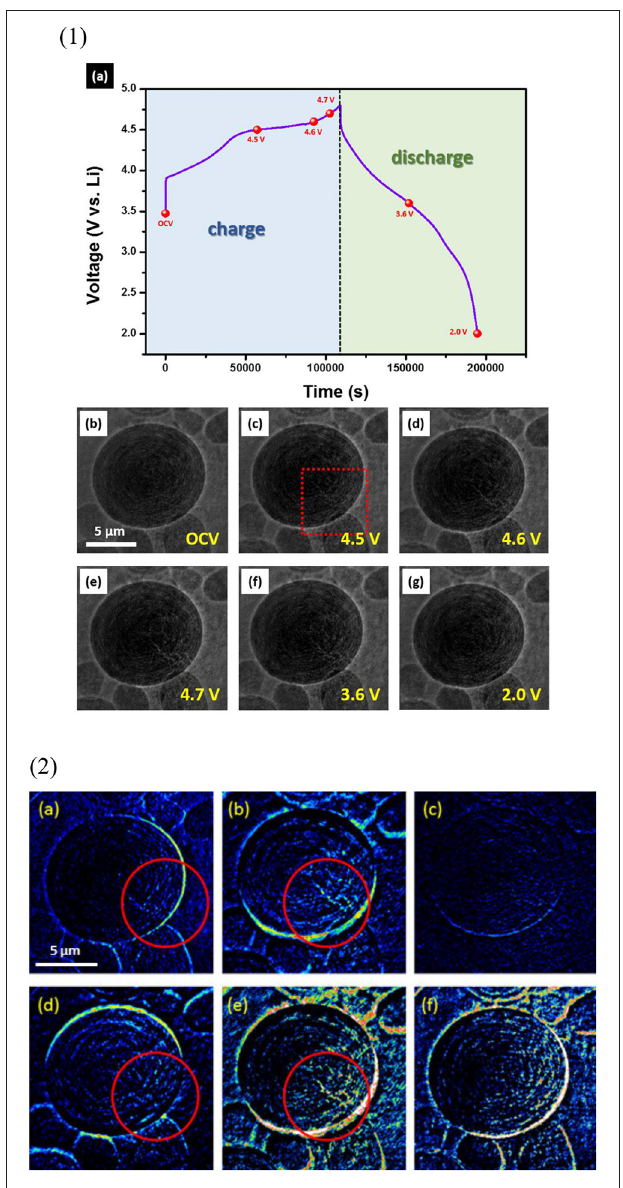
FIGURE 2 | TXM images of a working Li 2 MnO 3 · LiMO 2 cathode particle. (1) (a) Voltage (V vs. Li + /Li) vs. time curve during the first charge/discharge cycle. (b – g) are the corresponding snapshots of the marked numbers in (a) . (2) Variation in TXM images in ( 1b–g ). ( 2a–f ) represent the differences between 4.5V and open-circuit voltage (OCV), 4.7 and 4.5V, 3.6 and 4.7V, 2.0 and 3.6V, 4.7V and OCV, and 2.0V and OCV, respectively. Reprinted permission from Chen et al. (2016). Copyright 2016 American Chemical